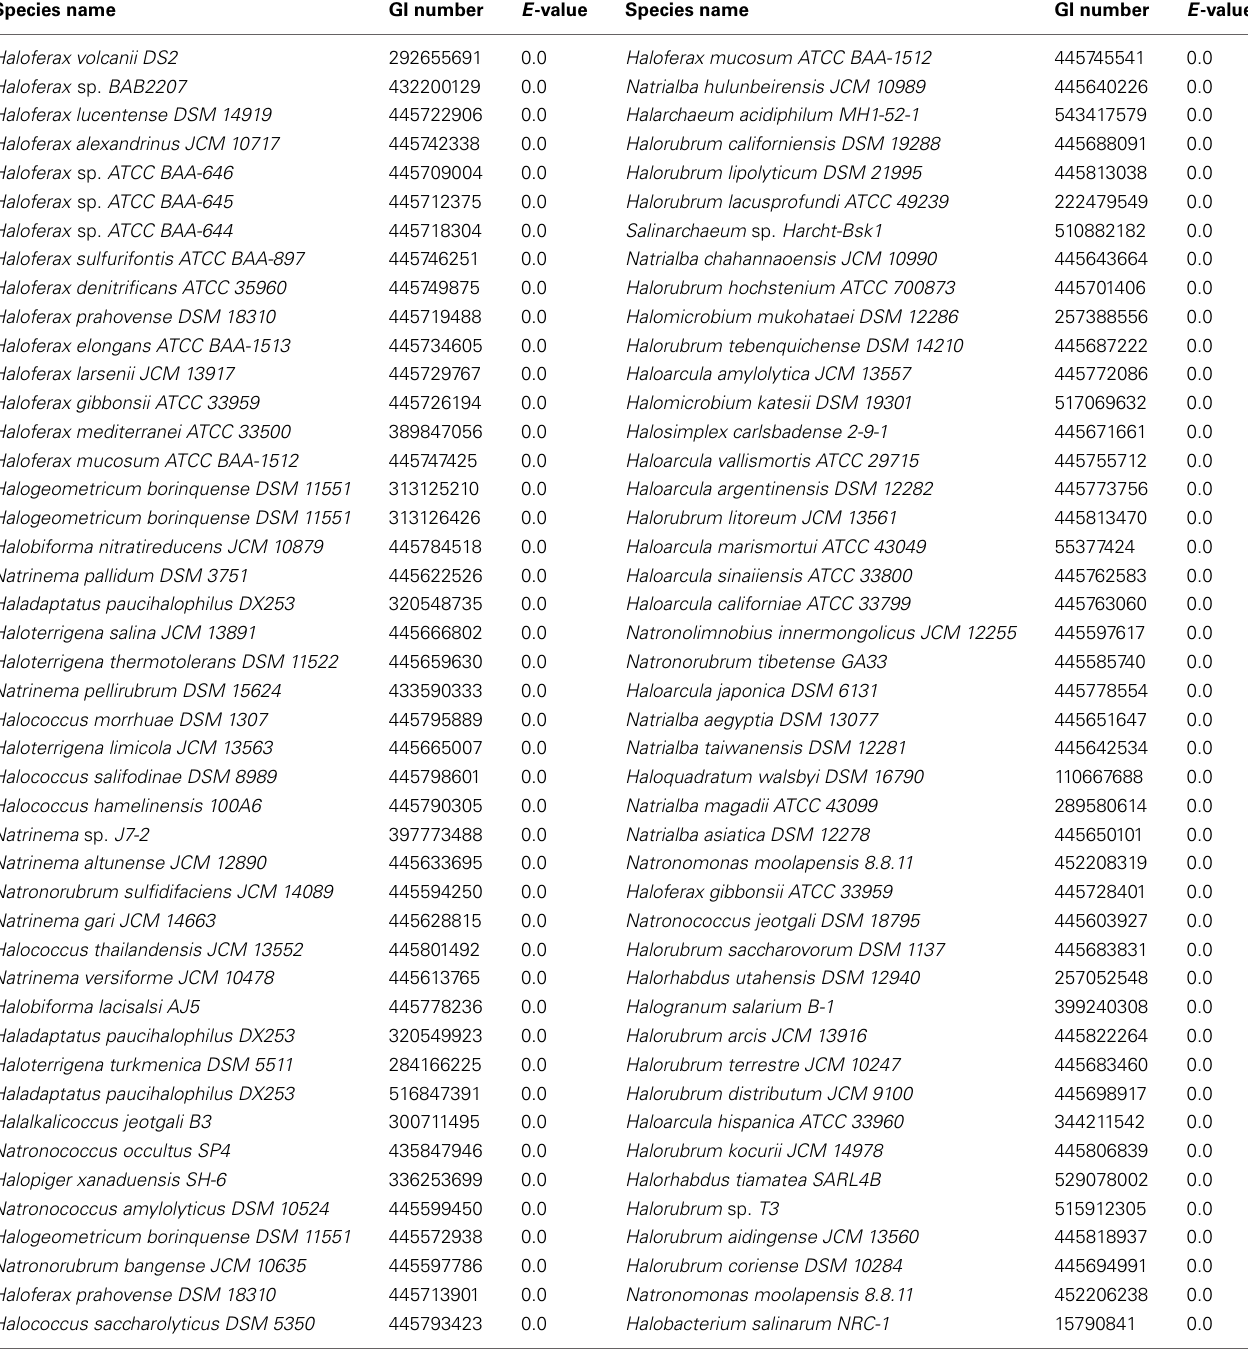
Table 5 | Results of BLASTp search using glpK (Performed on September 17,